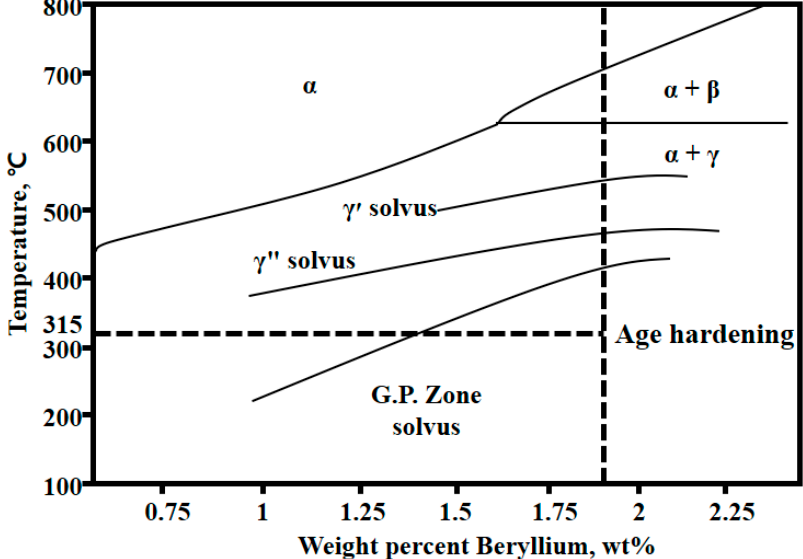
Figure 3. Phase diagram and metastable solvus of the beryllium-copper alloy.